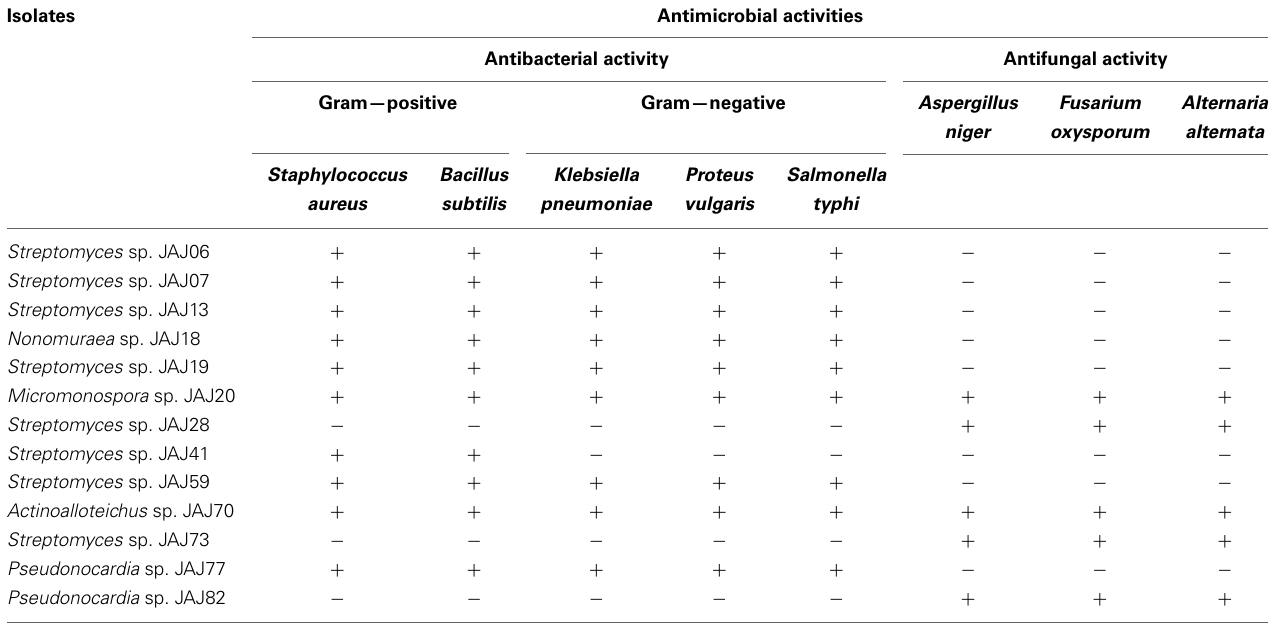
Table 1 | Range of antimicrobial activities of the actinomycete isolates obtained from Indian inland (Jose and Jebakumar, 2013a) and coastal (Jose and Jebakumar, 2013b) solar